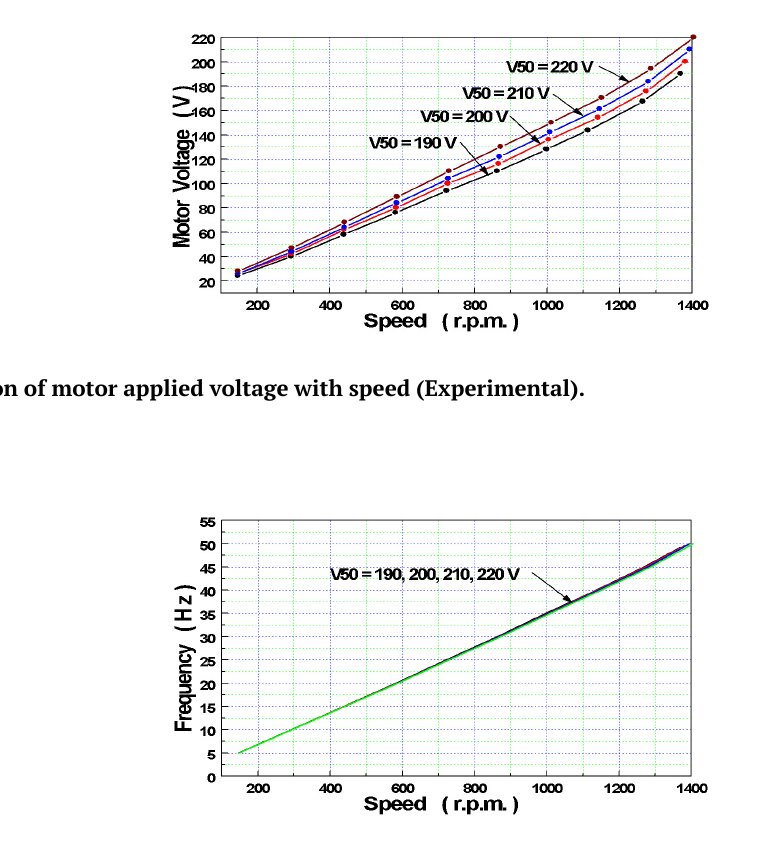
Fig. 11. Variation of frequency with speed